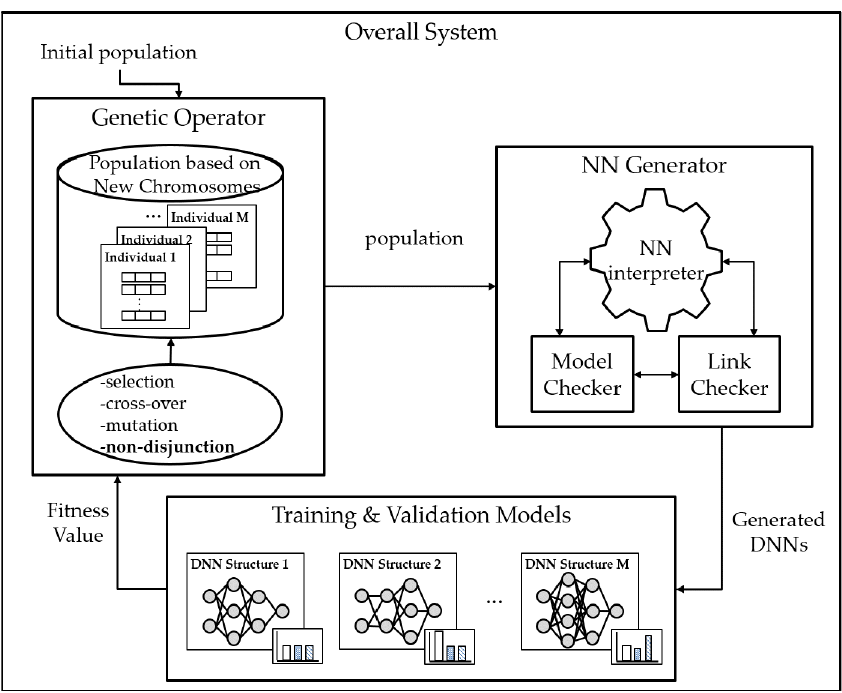
Figure 3. System of modified NAS method.